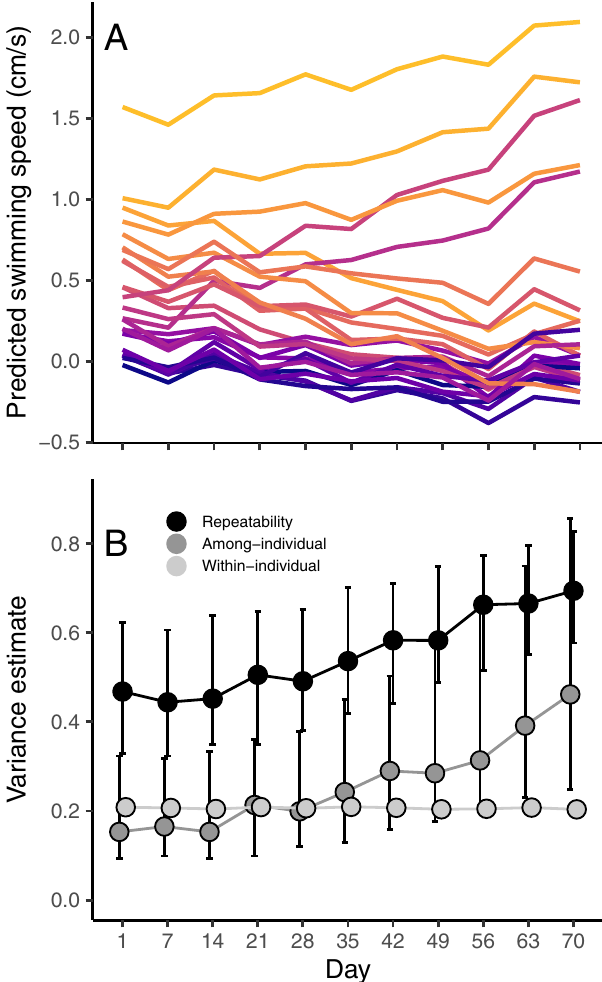
Fig. 3 | Individuality increases gradually throughout the fi rst 70 days of development. Thepredictedvaluesofmedianindividualswimmingspeeddiverge over time ( A ) leading to gradual increases in the among-individual variance and hence repeatability ( B ) of behavior.These modelsincludedonly the 26 individuals onwhichwehadcompletedataforthe fi rst10weeksoflifetoensurethatabsolute levels of variation would remain comparable over time. Individual lines in ( A ) are colored according to their predicted behavior in week 1 with yellow indicating greater swimming speeds and purple indicating lower swimming speeds. In ( B ), shown are the posterior modes of each variance estimate and its 95% CI. Source Data are provided as a Source Data fi